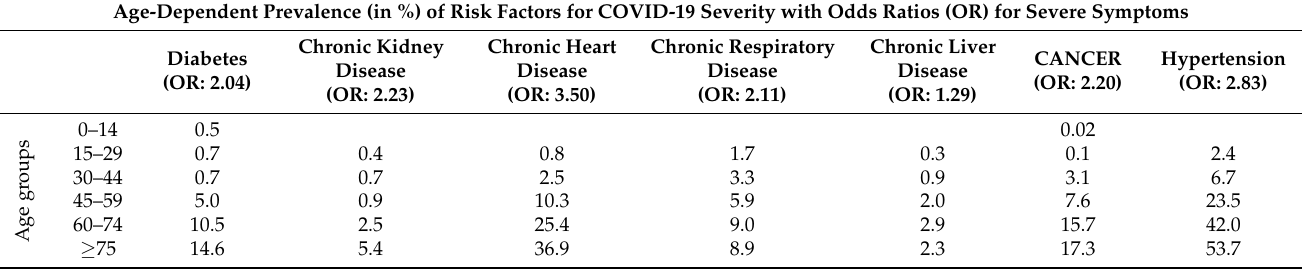
Table A3. Prevalence and effects of risk factors for increased risk of severe COVID-19 [28,45,46]. Age-Dependent Prevalence (in %) of Risk Factors for COVID-19 Severity with Odds Ratios (OR) for Severe